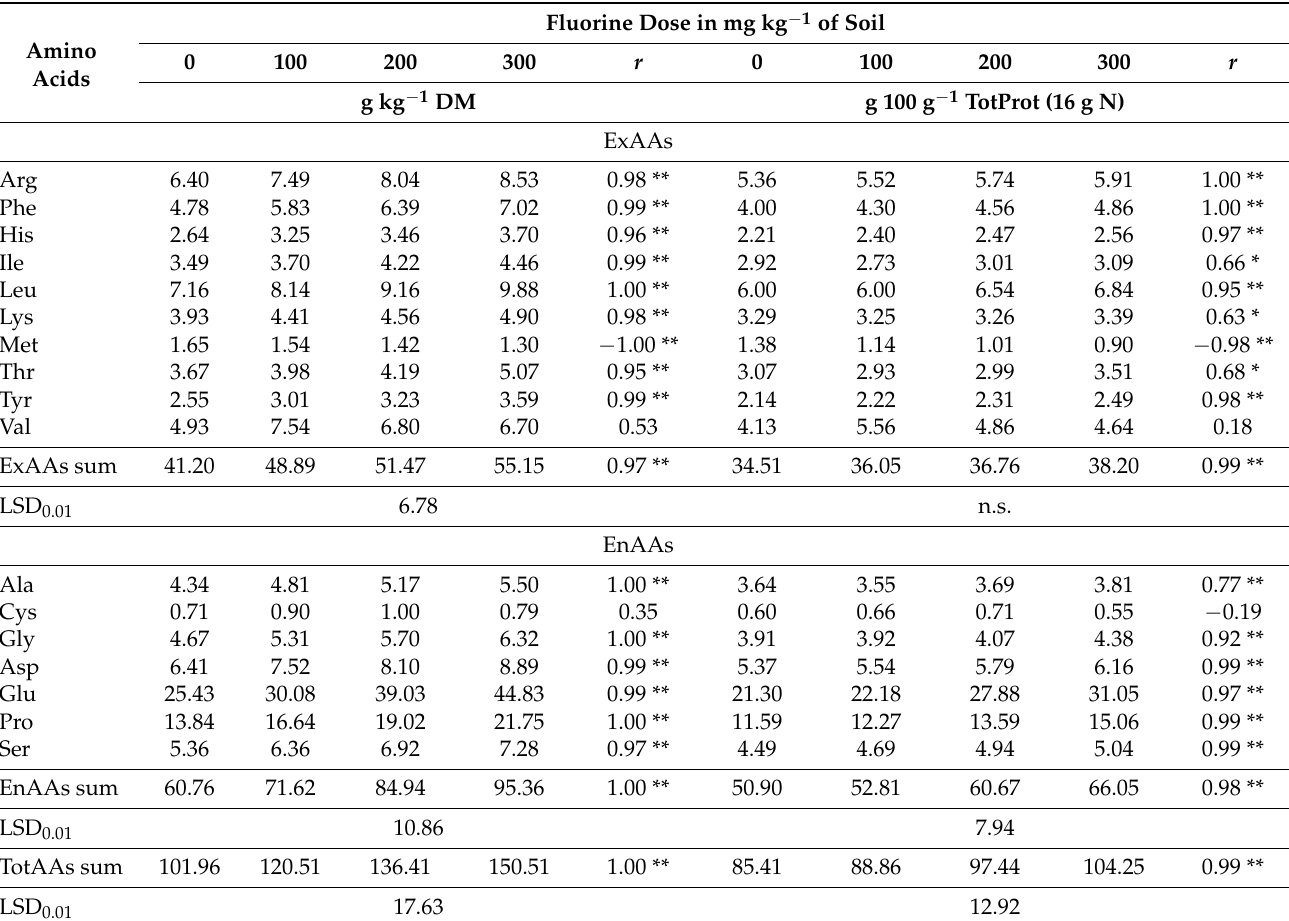
Table 4. The content of amino acids in the grain of spring triticale ( × Triticosecale Wittm . ex A. Camus).